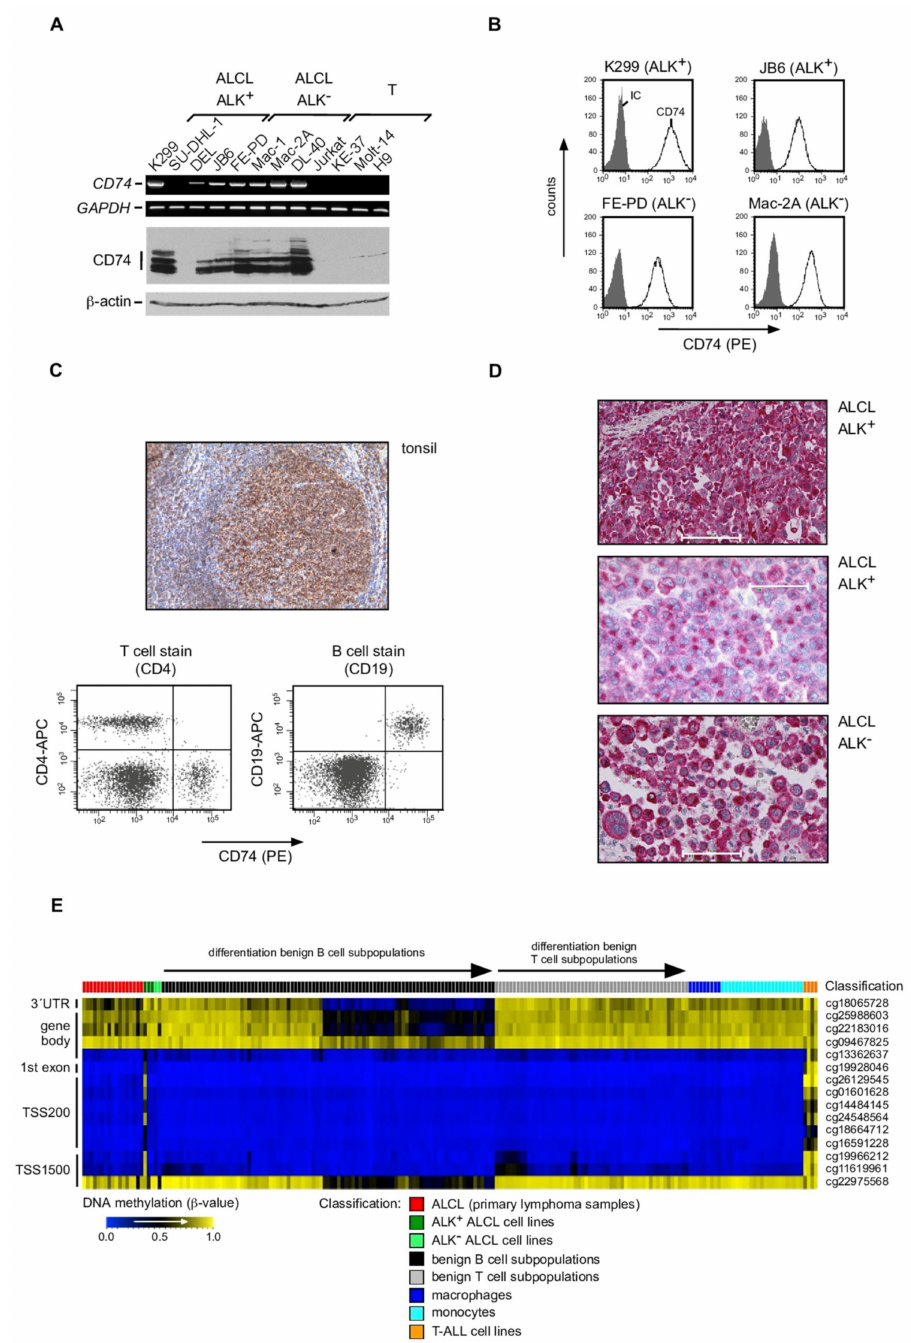
Figure 1. CD74 expression in ALCL. ( A ) Analysis of CD74 mRNA (upper panel) and protein (lower panel; antibody sc-6262) expression in various ALK + and ALK − ALCL as well as T cell control cell lines, as indicated. The expression levels of GAPDH and of β -actin were analyzed as controls, respectively. Note, that various CD74 protein bands of different sizes are detectable. ( B ) Cell surface expression analysis of CD74 in two ALK + (K299, JB6) and two ALK − (FE-PD, Mac-2A) ALCL cell lines by extracellular flow cytometry (antibody sc-20062). Open histogram, CD74 staining; filled histogram, isotype control (IC). ( C ) Physiological CD74 protein expression in the human B cell compartment. Upper panel, CD74 immunohistochemistry (IHC) in normal human tonsillar tissue. Note that the B cell compartment including the germinal center strongly stains for CD74 (brown signal), whereas the T cell compartment lacks CD74 expression. Lower panels, expression analyses of CD74 on T and B cells of human peripheral blood. Left, CD74 and CD4 double-staining of human peripheral blood mononuclear cells (PMNC). Note, that CD4-positive cells (upper left quadrant) do not stain for CD74. Right, CD74 and CD19 double-staining of human PMNC of peripheral blood. Note that CD19-positive cells do express